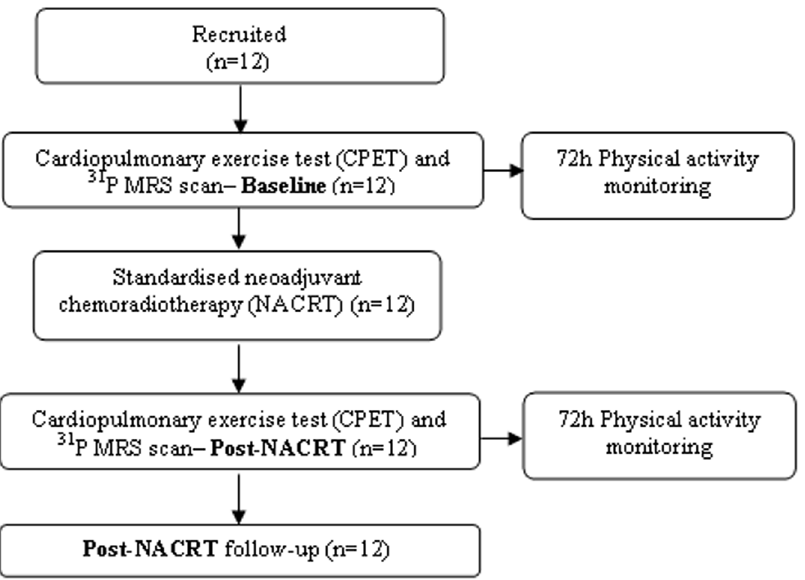
Figure 1. Showing flow of patients through the study protocol. Post-NACRT tests carried out within 48 ¡ 5 hours of finishing NACRT